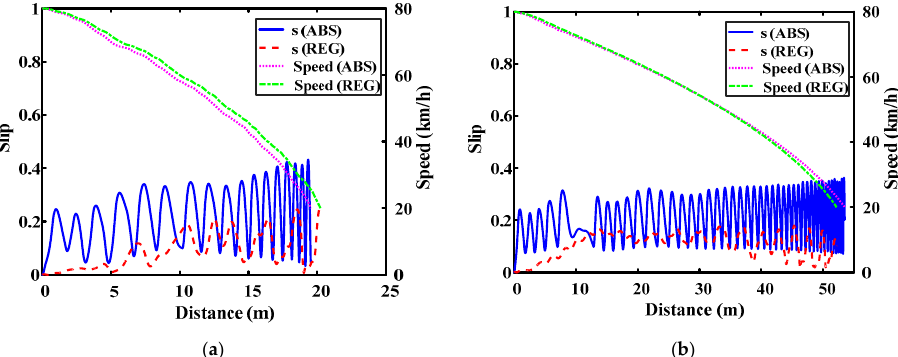
Figure 17. Slip and vehicle speed. High adhesion surface ( a ); Low adhesion surface ( b ).